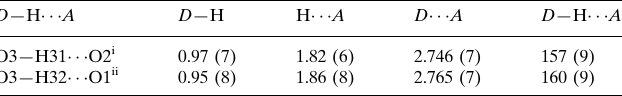
Hydrogen-bond geometry (A˚ , (cid:2)